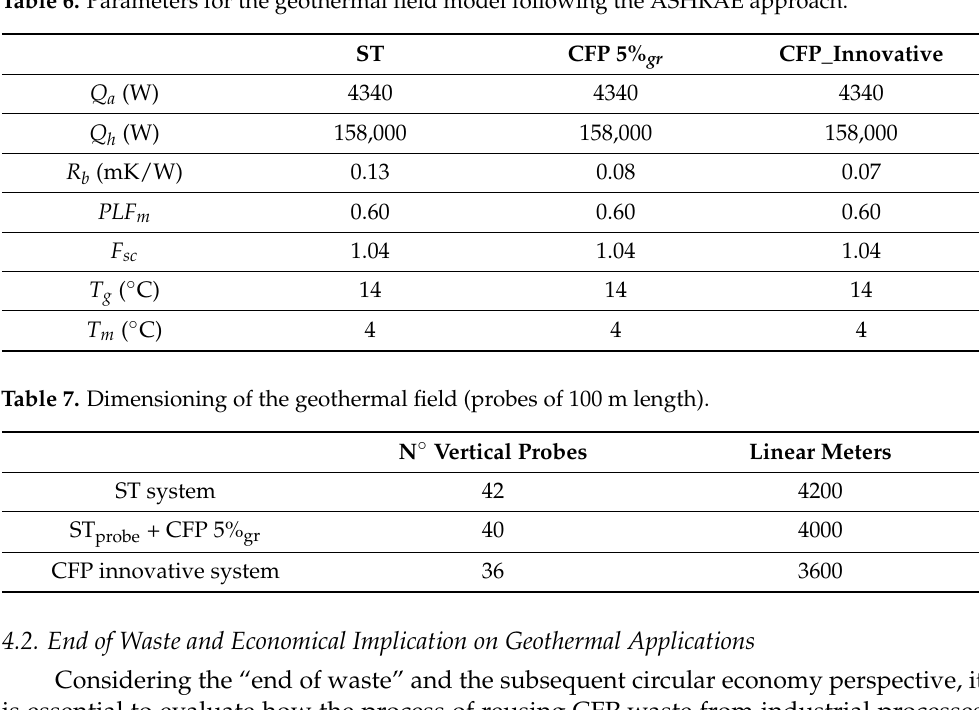
Table 6. Parameters for the geothermal field model following the ASHRAE approach.